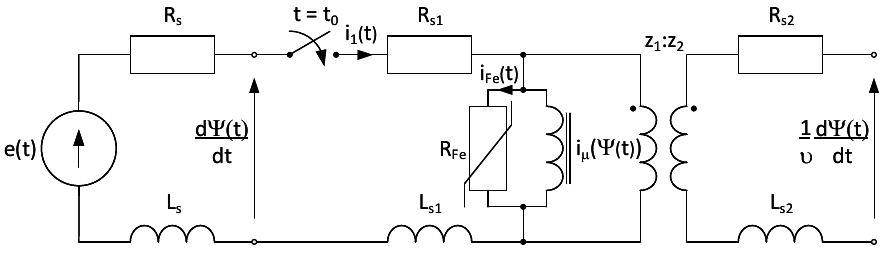
Figure 1. Equivalent diagram of a single-phase transformer.